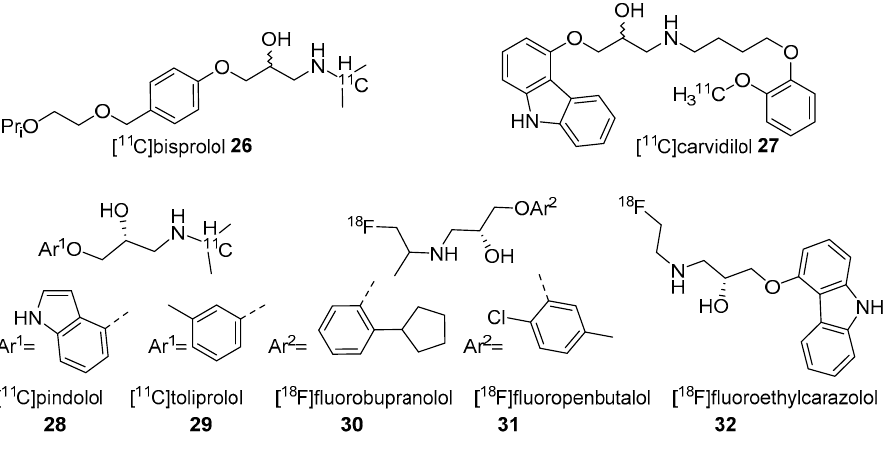
Figure 9. Radiotracers based on various β -AR blockers.